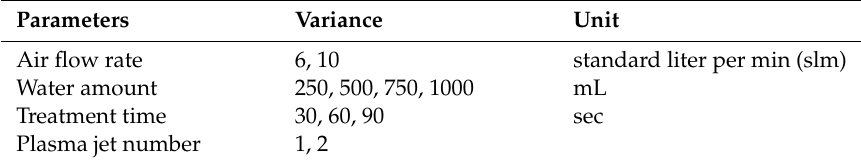
Table 1. The operating parameters of plasma-activated water (PAW) to inactivate S . Enteritidis on shell